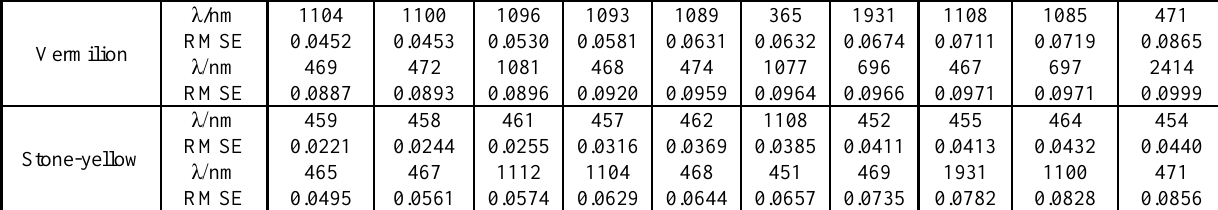
Table3 Strong linear bands derived from mixture of vermilion and stone-yellow (1) The analysis results of full-band spectral mixture model show that the mixtures of vermilion and stone-yellow mineral and show strong